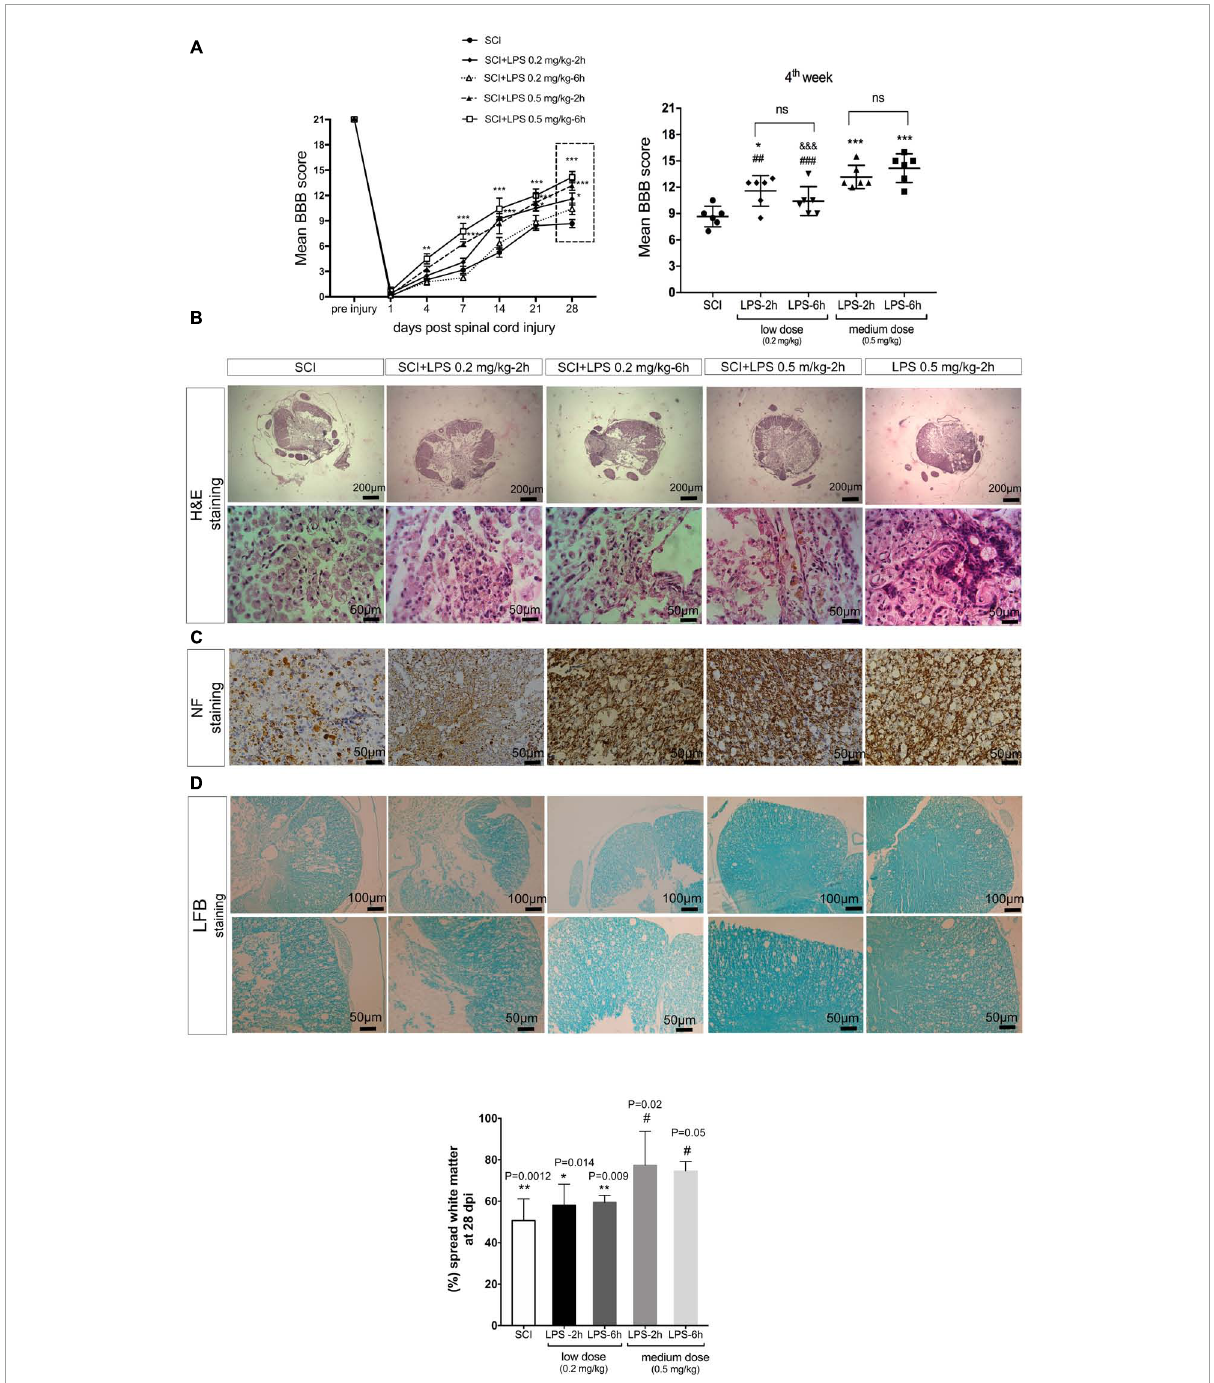
FIGURE5 Lipopolysaccharide administration improves hind-limb locomotor function and histological alternations after the SCI. (A) Un-treated (SCI) group show spontaneous partial recovery of the hind-limb during 28 days. Animals that received LPS 0.2 mg/kg and LPS 0.5 mg/kg at 2 and 6 h post-treatment showed a gradual increase in BBB score during 28 days post-SCI. Comparison of the average BBB score at 4 weeks after SCI demonstrated that rats received 0.5 mg/kg LPS at 2 or 6 h post-SCI, have higher BBB scores in comparison to another group (D) . n = 6 for each group. Values represent as means ± SEM. *** P < 0.001 (compared with SCI), # P < 0.05, ## P < 0.01 (compared with LPS 0.5 mg/kg-6 h group at day 28), &&& P < 0.001 (compared with LPS 0.5 mg/kg-2 h group at day 28). (B) Hematoxylin and eosin stained cross-sections at the injury epicenter. A small number of axonal transections (arrows) were detected. (C) NF-200 immunohistochemistry staining illustrated fewer NF-200 positive cells in the SCI group and LPS 0.2 and 0.5 mg/kg increased the NF-200-positive cells at 28 days post-injury in each group. (D) White matter area (WMA) at the lesion segment at 4 weeks. WMS represents the spared WMA at the epicenter divided by the WMA of control sections of intact animals. Scale bar, 20 µ m. n = 3 for each group. * P < 0.05 and ** P < 0.01 versus sham. # P < 0.05 versus